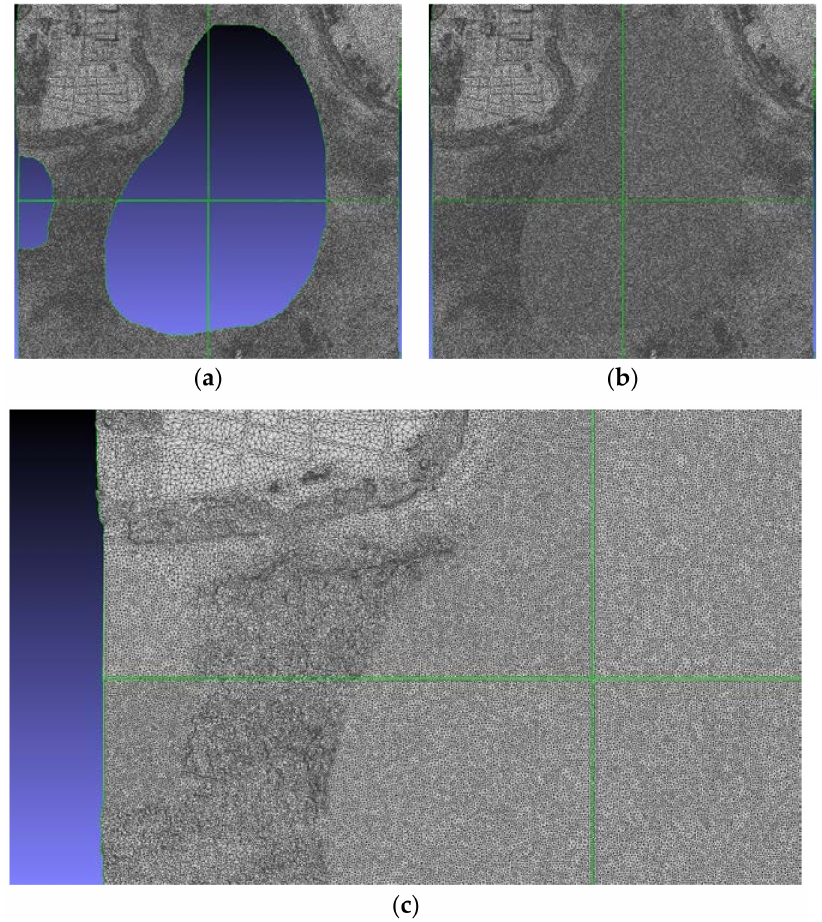
Figure 16. Hole filling results obtained via the method proposed in this article: ( a ) open hole closure; ( b ) hole filling; ( c ) hole filling